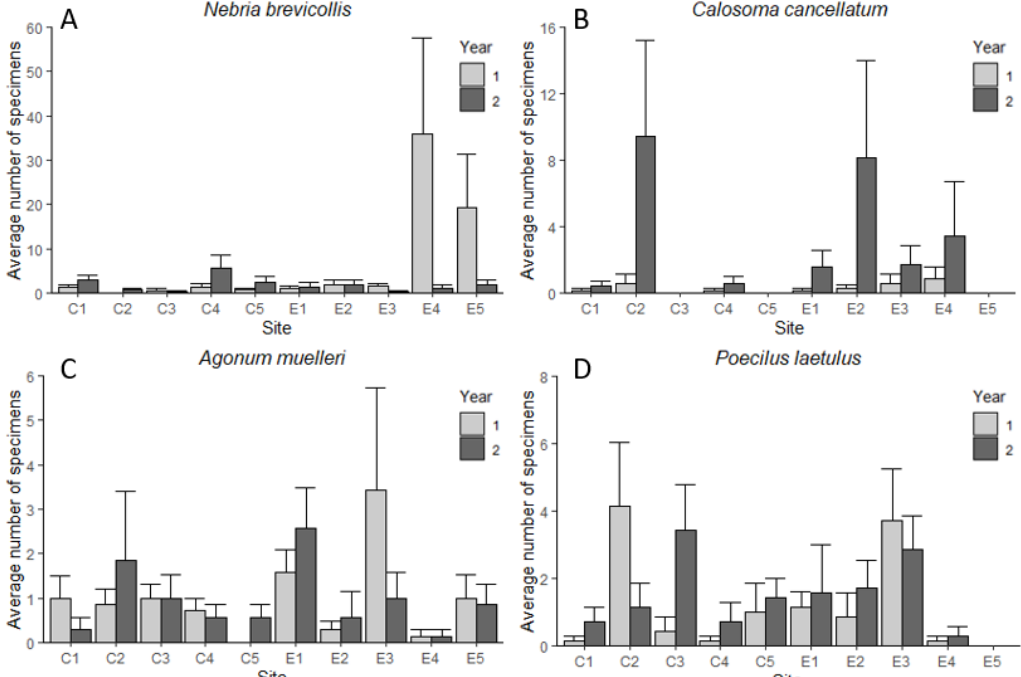
Figure 3. Average number + standard error of Nebria brevicollis ( A ), Calosoma cancellatum ( B ), Poecilus laetulus ( C ) and Agonum muelleri ( D ) in each site compared between year 1 (23 March–13 June 2018) and year 2 (26 March–20 June2019). The data are based on seven sampling occasions per year at each site.